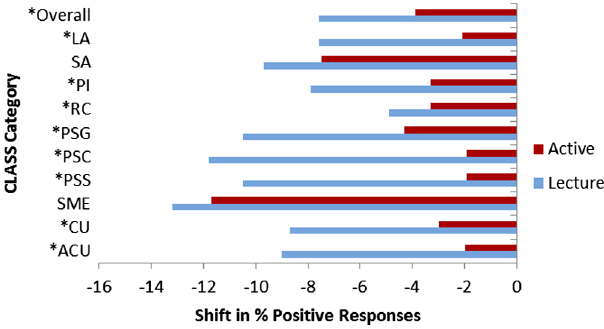
FIG. 5. CLASS shifts from pre-Fall to post-Spring for students in Active Physics and traditional-lecture physics. (cid:1)ð p < 0 . 05 Þ for instruction-type main effects in regression.